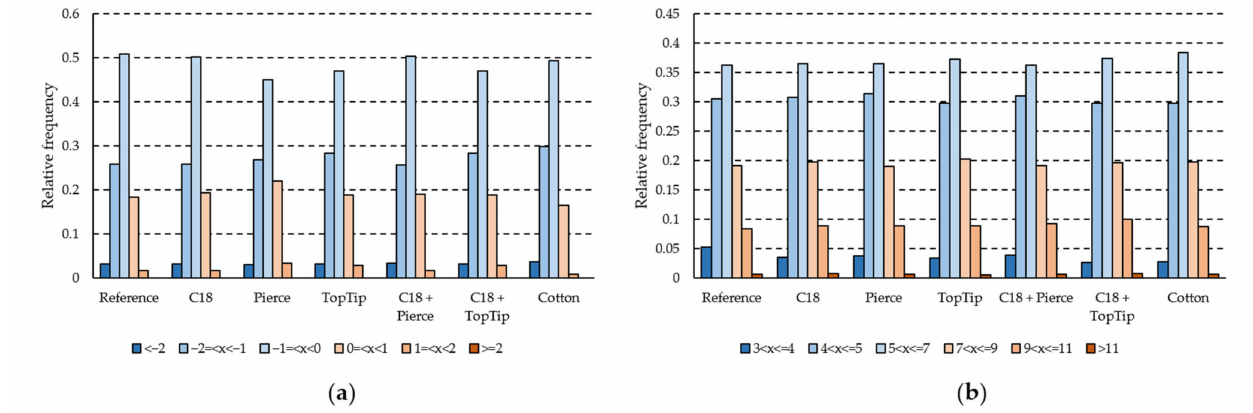
Figure A1. ( a ) GRAVY score distribution of peptides detected with each SPE method. ( b ) Isoelectric point distributions of peptides detected with each SPE